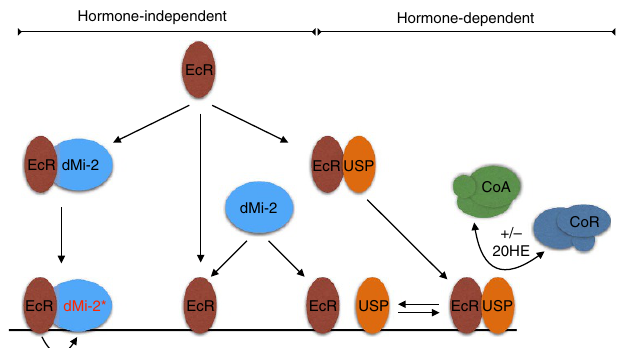
Figure 7 | Model. Model detailing hormone-dependent (bimodal switch model) and hormone-independent modes of gene regulation by